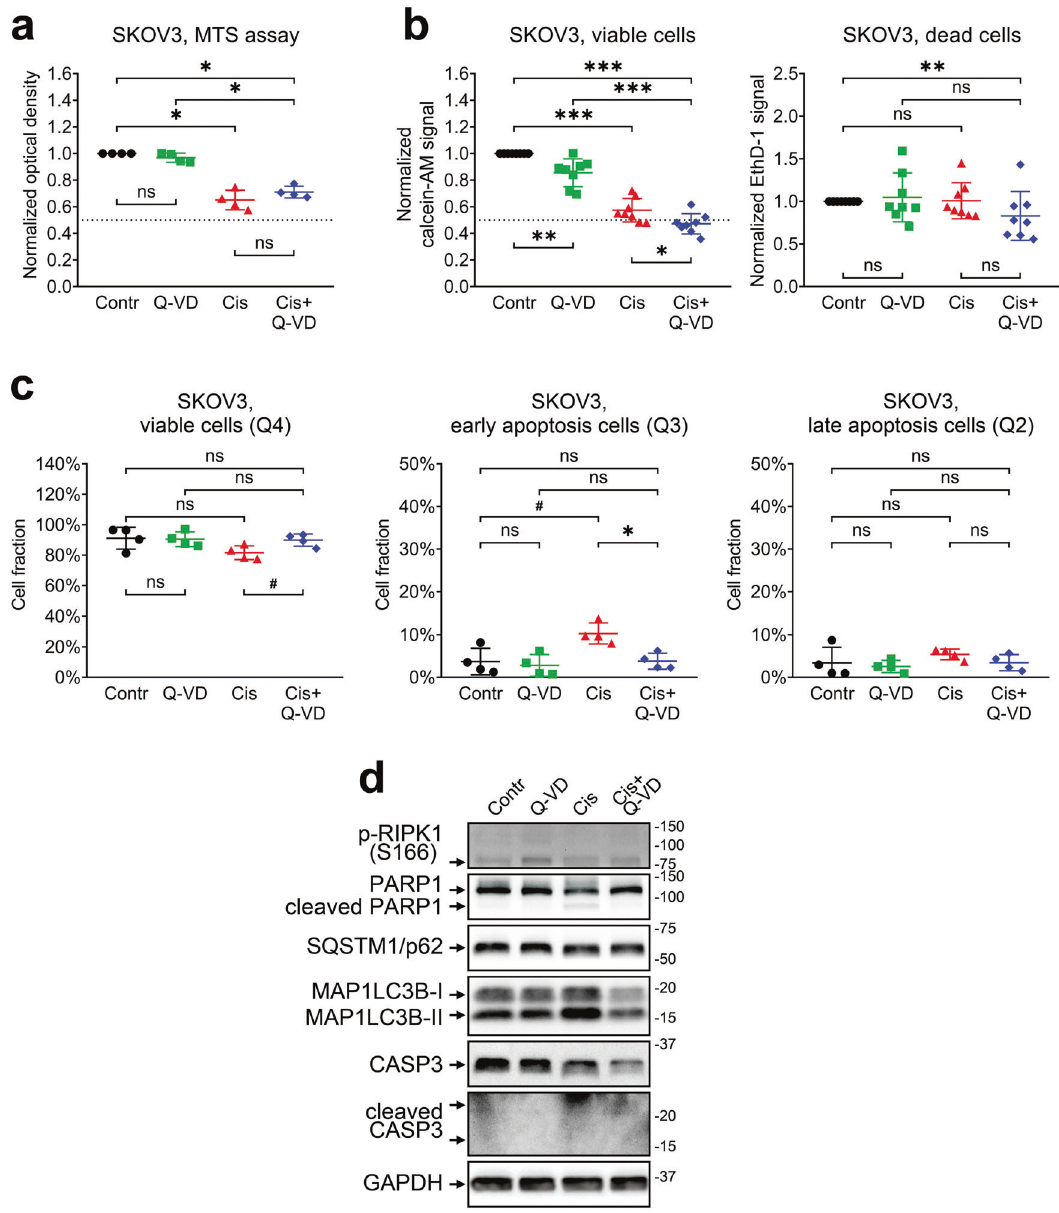
Fig. 5 Cytotoxic and cytostatic effects of cisplatin treatment in SKOV3 cells. The cells were treated with 5 μ M cisplatin in the presence or absence of 25 μ M of Q-VD. a Relative optical density values obtained via the MTS assay. The data are normalized to the respective “ Contr ” sample; the lines and whiskers indicate mean ± standard deviation, N = 4. The dashed line indicates a 50% reduction in the MTS signal. b Calcein-AM and EthD-1 signals were obtained via the LIVE/DEAD assay. The data are normalized to “ Contr ” sample; the lines and whiskers indicate mean ± standard deviation, N = 8. The dashed line indicates a 50% reduction in the calcein-AM signal. c Fractions of viable and apoptotic cells estimated via the Annexin V/PI assay. The lines and whiskers indicate mean ± standard deviation, N = 4. d Western blot analysis of protein levels. The samples are indicated above; the proteins of interest are indicated on the left; molecular weight markers are indicated on the right. “ Contr ” – control samples; “ Cis ” –